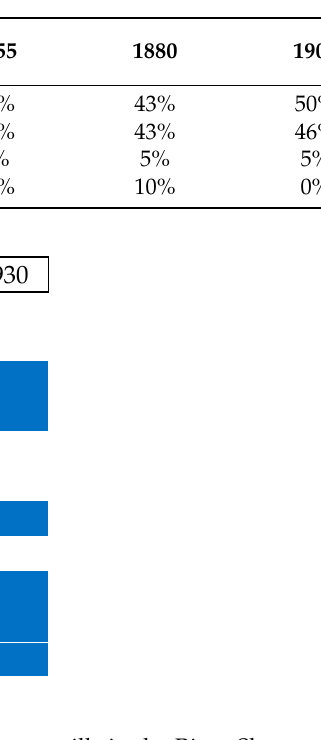
Figure 2. Number of gristmills [G] and sawmills [S] broken down into the main physico-geographical regions of the River Skawa catchment in the years 1855, 1880, 1909, 1930. Table 3. The share of sawmills in the total number of water-wheel-driven devices in the years 1855–1930.